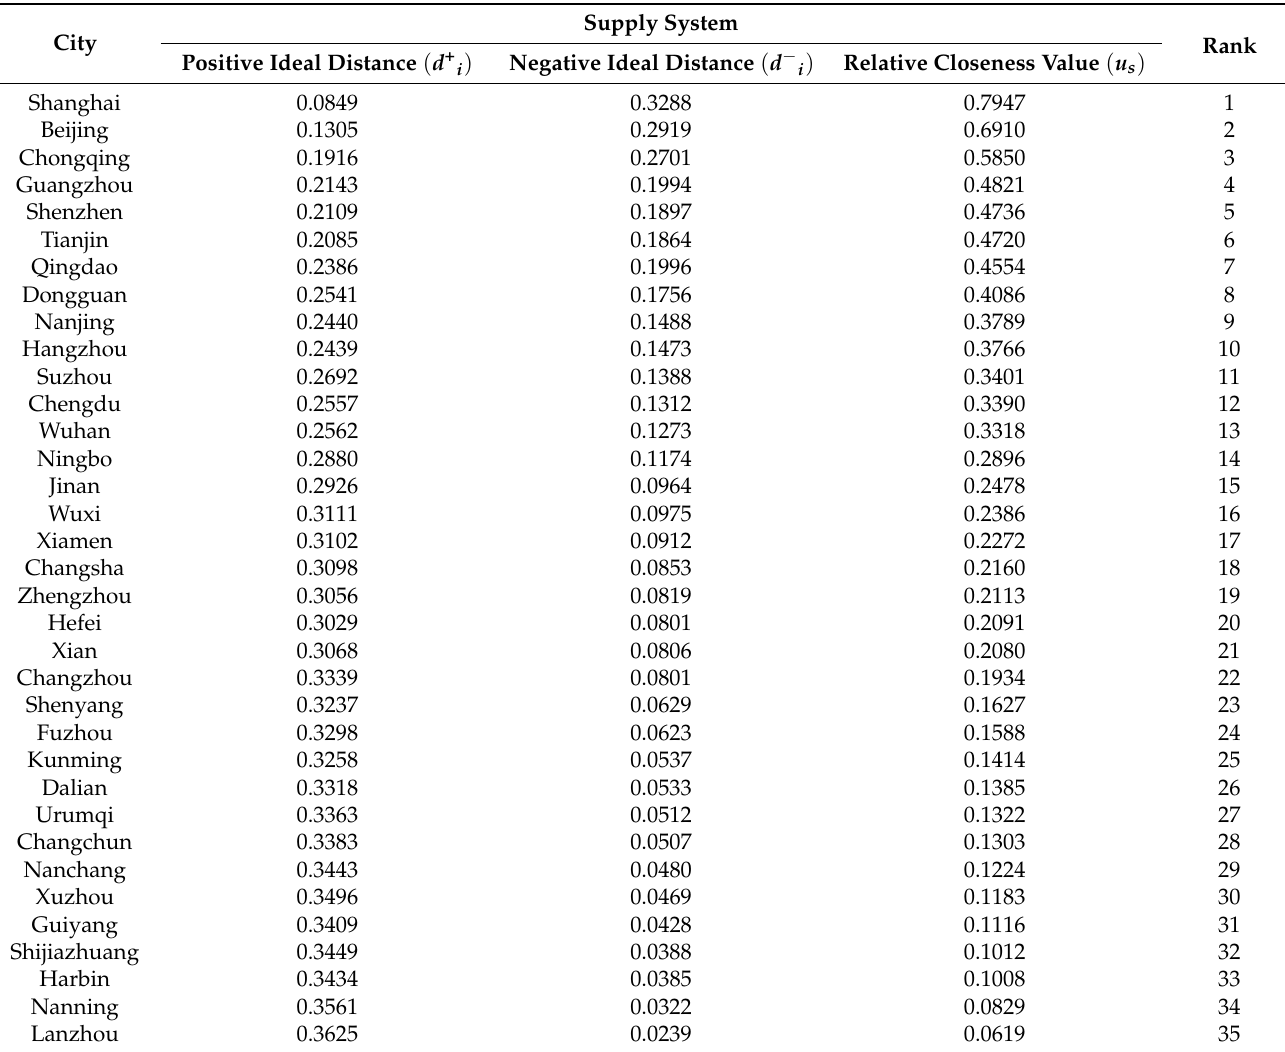
Table 6. TOPSIS values of supply